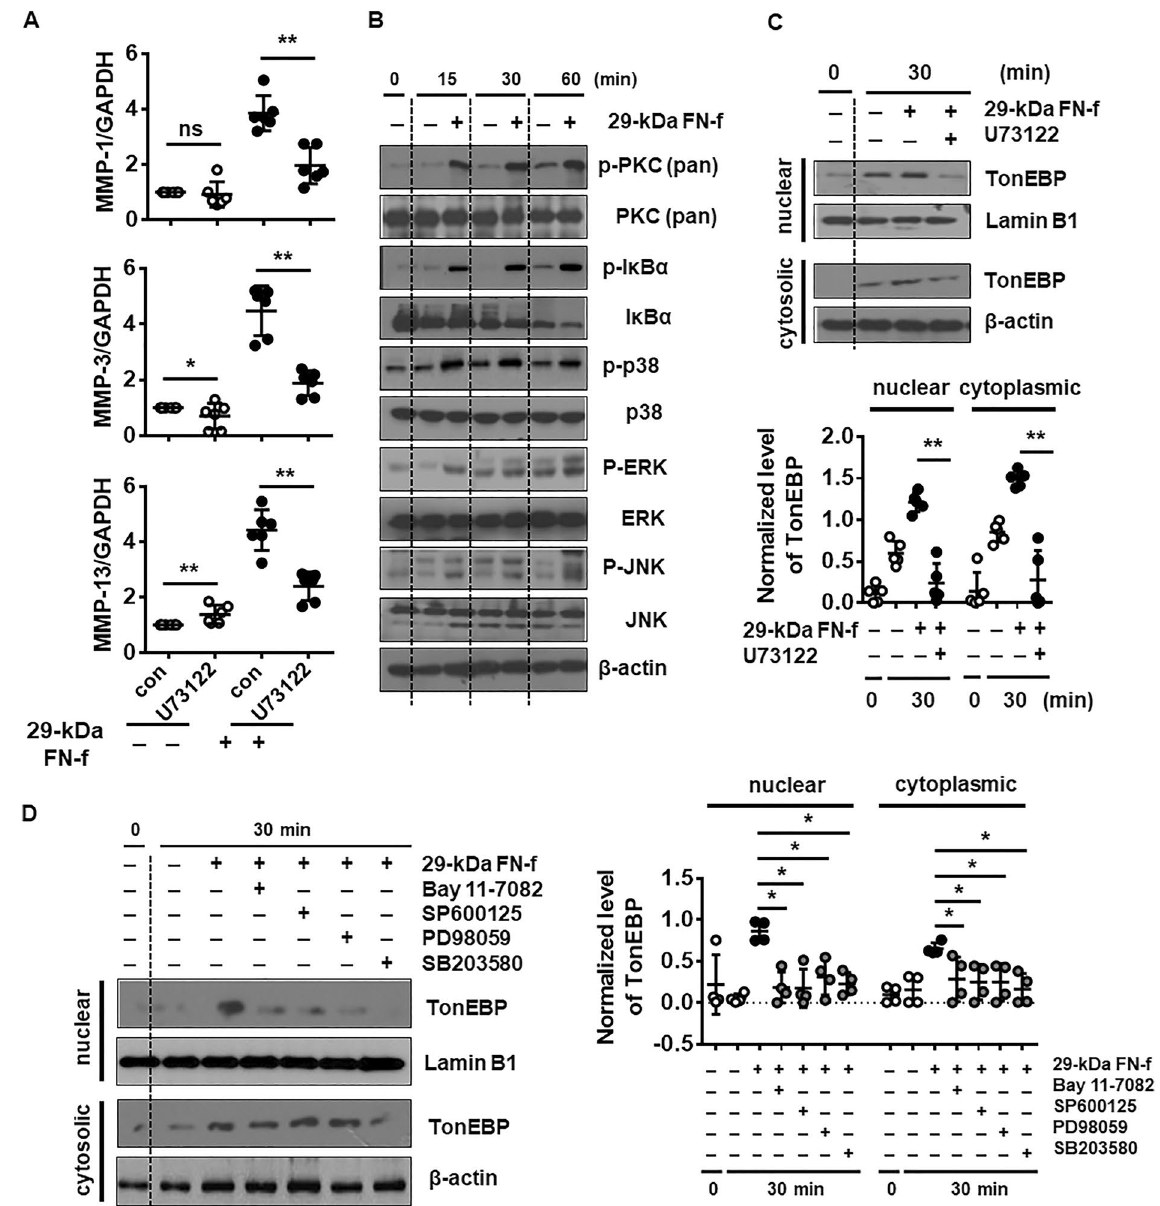
Figure 3. 29-kDa FN-f induces nuclear accumulation of TonEBP via the PLC/NF-κB/MAPK signaling pathway. ( A ) 29-kDa FN-f-induced MMP expression was suppressed by U73122 (a PLC-γ-specific inhibitor). Chondrocytes were pretreated with U73122 for 2 h and incubated with 29-kDa FN-f (300 nM) for 6 h. Expression levels of MMPs 1, 3, and 13 were measured by QuantiFast SYBR Green qRT-PCR. Data are expressed as the mean ± SD of duplicate data from three independent donors. * P < 0.05 and ** P < 0.01 vs. untreated control; ns, not significant. ( B ) 29-kDa FN-f activated PKC, NF-κB, and MAPK signaling. Chondrocytes were treated with 29-kDa FN-f (300 nM) for 15, 30, and 60 min. The levels of p-PKC/PKC, p-Iκ-Bα/ Iκ-Bα, p-p38/p38, pERK/ERK, and p-JNK/JNK were determined by western blot analysis. ( C ) 29-kDa FN-f increased nuclear accumulation of TonEBP via the PLC-γ signaling pathway. Cytoplasmic and nuclear fractions were isolated from chondrocytes treated with 29-kDa FN-f (300 nM) for 30 min after pre-treatment with U73122 for 2 h. The western blot shown is representative of blots from five independent donors. ( D ) Inhibitors of NF-κB and MAPK signaling decreased 29-kDa FN-f-induced nuclear translocation of TonEBP. Chondrocytes were pre-incubated with a variety of inhibitors for 2 h and stimulated with 29-kDa FN-f (300 nM) for 30 min. The level of TonEBP in nuclear and cytoplasmic fractions from cell lysates was measured by western blot analysis. The western blot shown is representative of blots from four independent donors. ( C , D ) Protein band density in western blot image was assessed by setting a threshold using Image J software version 1.51 (National Institutes of Health, Bethesda, MD, USA, https:// imagej. nih. gov/ ij/ downl oad. html). Levels of nuclear and cytoplasmic TonEBP were normalized to lamin B1 and β-actin, respectively. Data are expressed as the mean ± SD of band densities of western blots from four or five different donors. * P < 0.05 and ** P < 0.01 vs. 29-kDa FN-f-treated cells. U73122 (1 µM), PLC-γ inhibitor; Bay 11-7082 (5 µM), NF-κB inhibitor; SP6001250 (10 µM), JNK inhibitor; PD98059 (10 µM), MEK1/2 inhibitor;